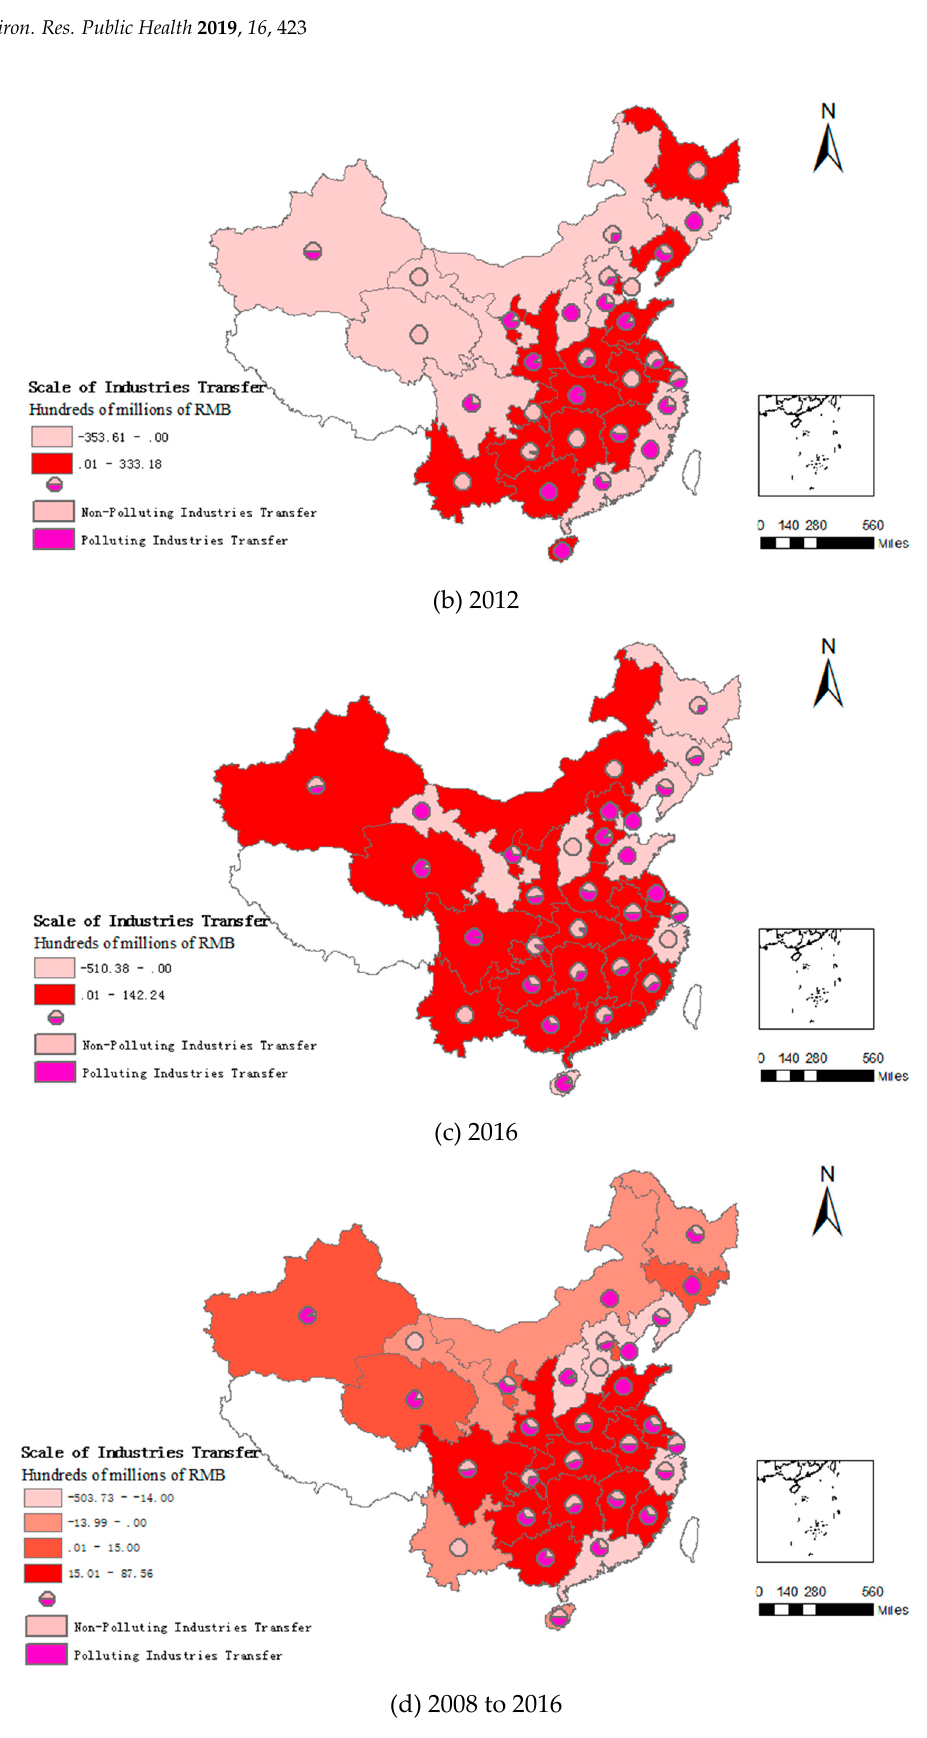
Figure 3. Spatial and temporal evolution of Chinese industry transfer: ( a ) 2008, ( b ) 2012, ( c ) 2016, ( d ) 2008 to 2016.